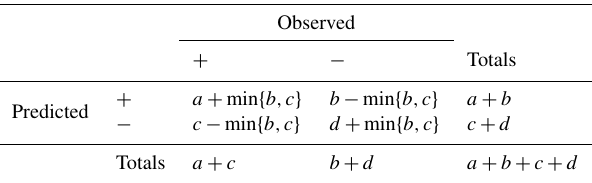
Table 5. Highest number of correct predictions relative to Table 2’s marginal